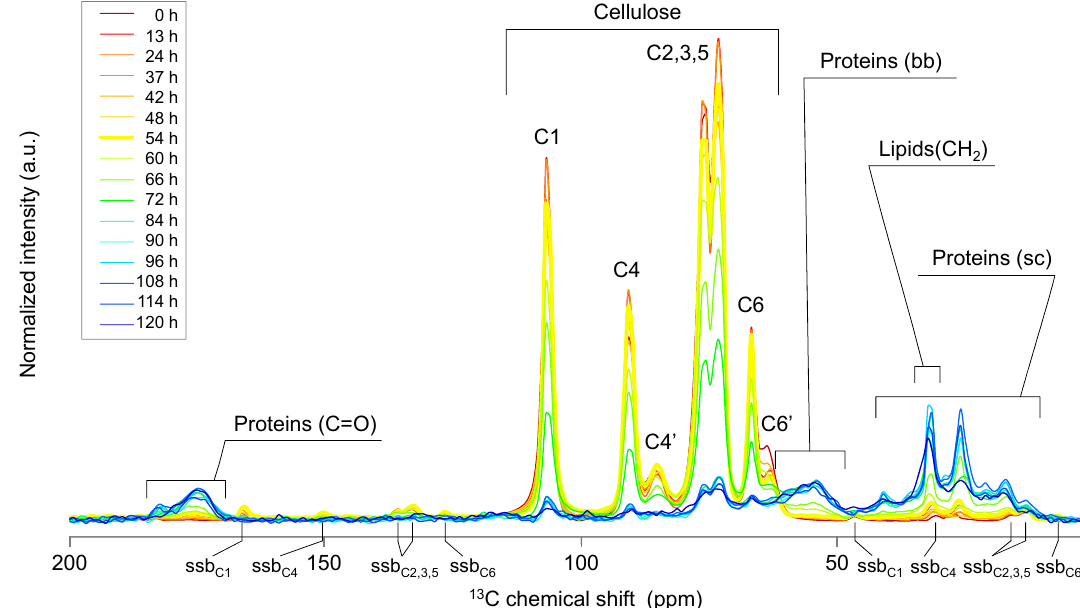
Figure 1. 13 C-CP/MAS-NMR spectra of anaerobic microbial degradation of BC. Sampling time is indicated by the colored lines described in the